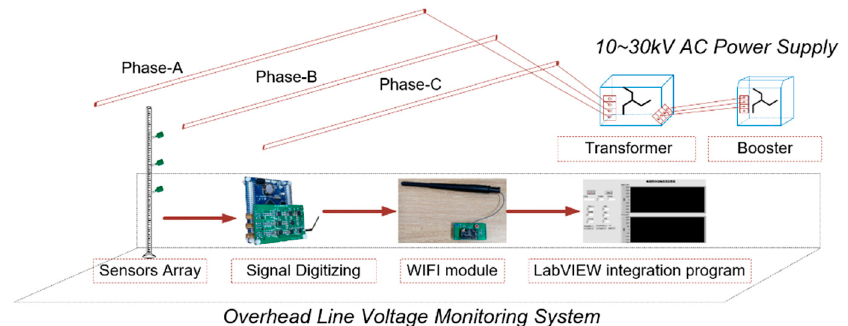
Figure 2. Framework of the overhead line voltage measurement system.